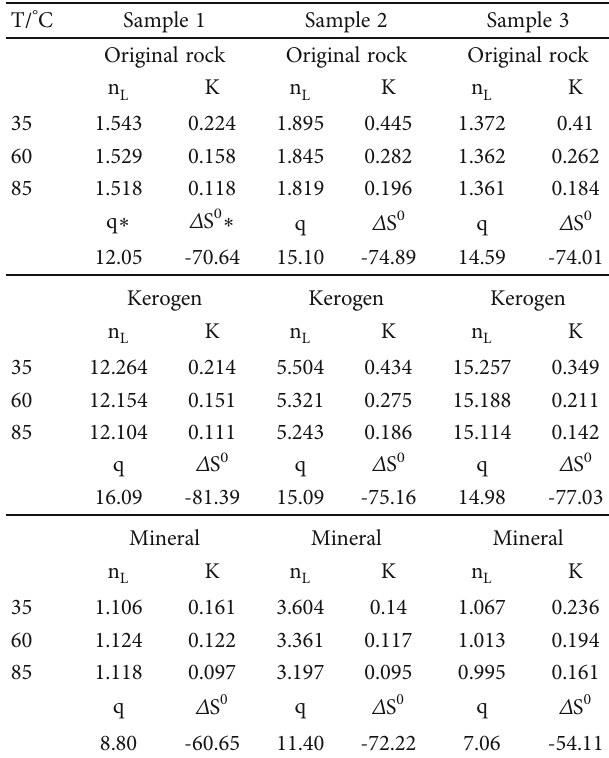
Table 4: Langmuir constant, maximal adsorption capacity n and thermodynamic